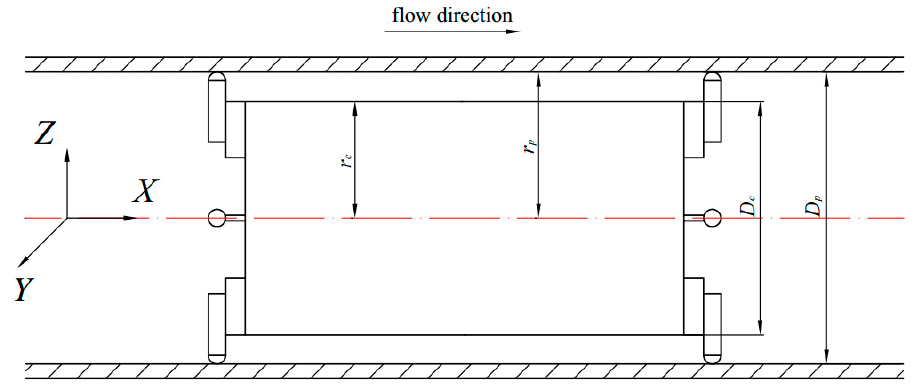
Figure 2. Figure 2. Capsule-coordinatesystem.